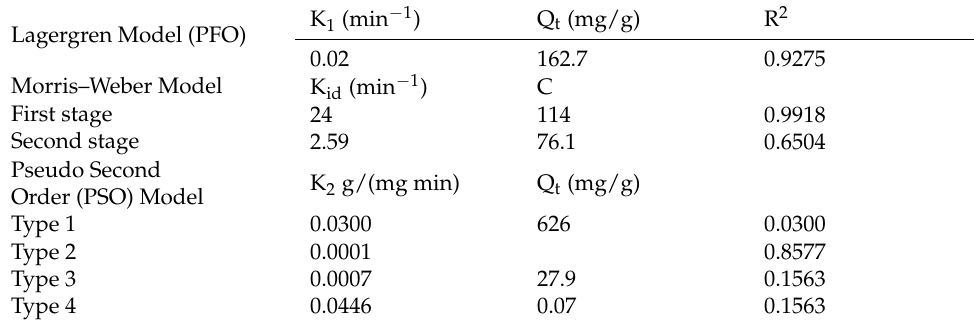
Table 1. Kinetic constants describing the rate of adsorption of AB 113 dye onto the IRA 402(Cl − ).